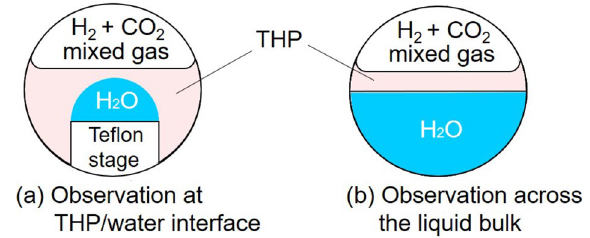
Figure 8. Schematic diagram of the test